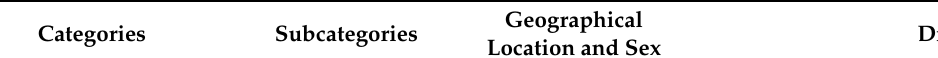
Table 11. Emotional expression on social networks.